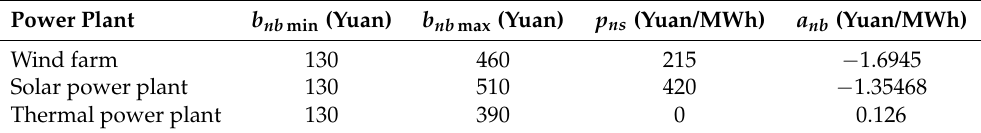
Table 2. Price parameters of power plants.